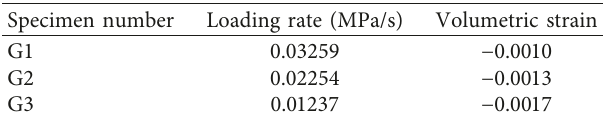
Figure 8: Plots of volumetric strain and pressure with time during fracturing. (a) W1 loading rate: 0.09552MPa/s. (b) G1 loading rate: 0.03259MPa/s. (c) W2 loading rate: 0.07328MPa/s. (d) G2 loading rate: 0.02254 MPa/s. (e) W3 loading rate: 0.06368MPa/s. (f) G3 loading rate: 0.01237MPa/s. Table 2: The volumetric strain of the specimens under the water fracturing pressure (4MPa).